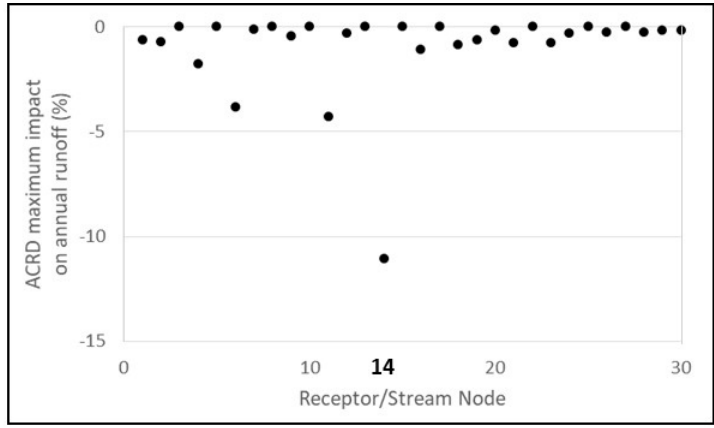
Figure 3. Additional coal resource development (ACRD) maximum impact on annual runoff (presented as the reduction in absolute annual runoff expressed as a percentage of the mean annual runoff).